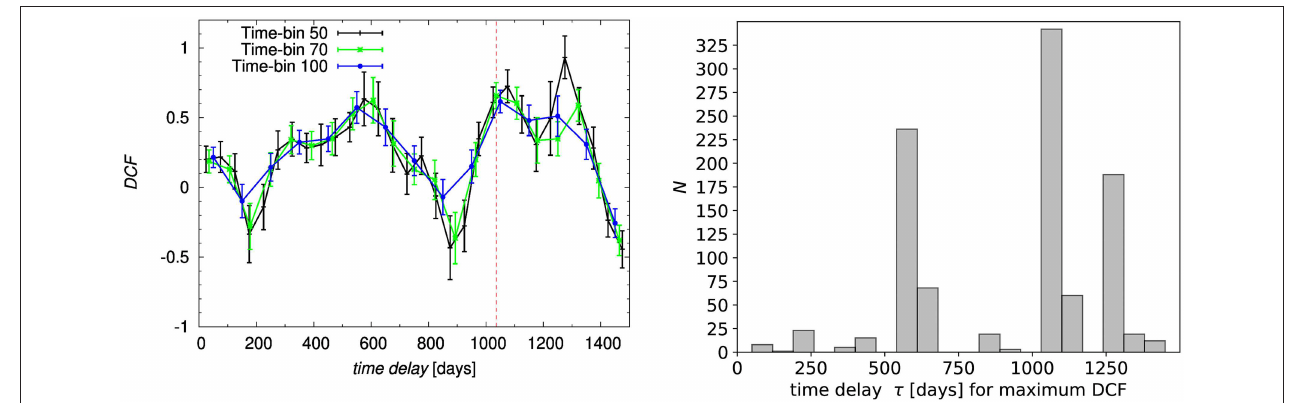
FIGURE 3 | Results of the Discrete Correlation Function (DCF). (Left) DCF as a function of time-delay in the observer frame for three different sizes of the time-bin: 50, 70, and 100 days, see the legend. The largest DCF is consistently at the time-delay of 1,050 days for bigger time-steps of 70–100 days. (Right) Histogram of 1,000 bootstrap runs using random subsample selection. The largest peak is at τ DCF